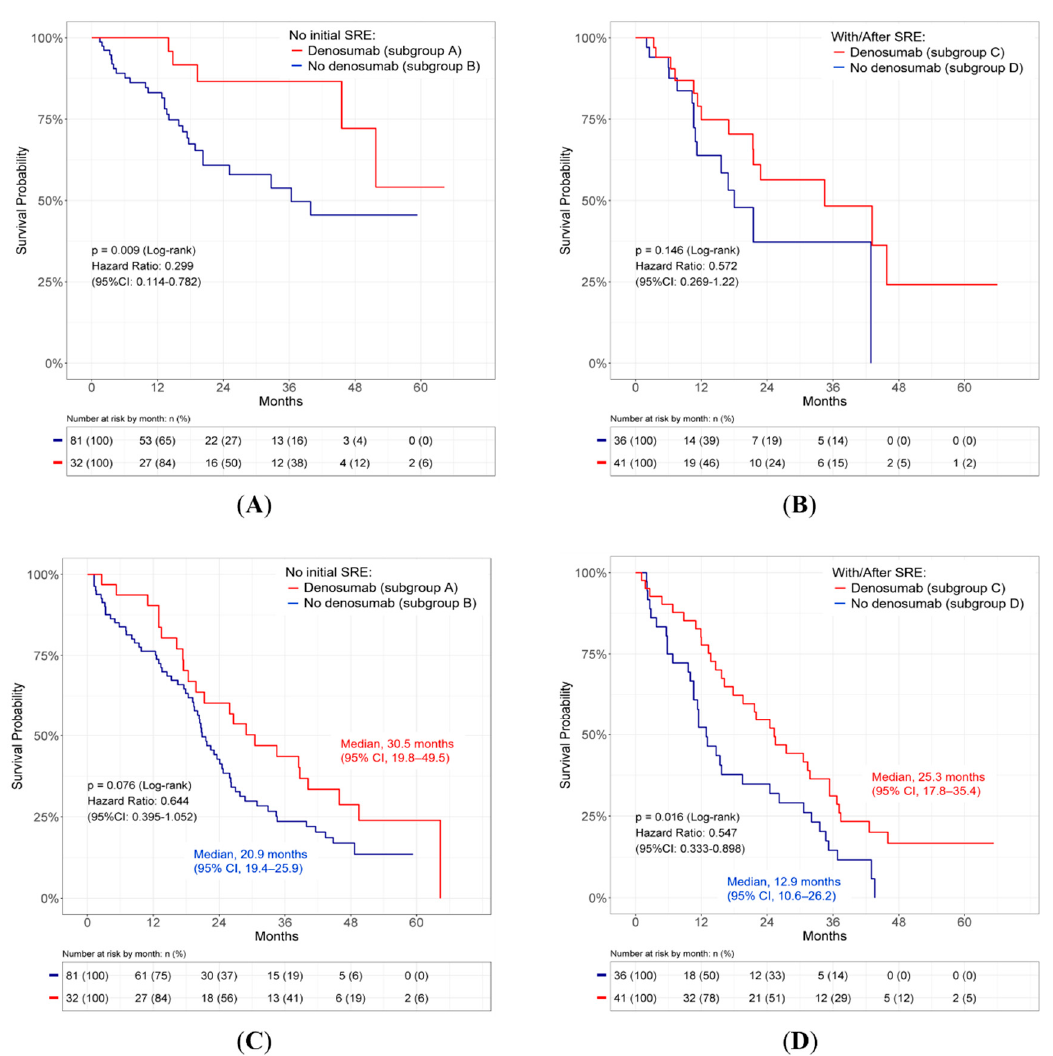
Figure 5. Subgroup analyses of denosumab’s effect on ( A ) SRE-FS in patients without initial SRE who did or did not receive denosumab therapy, ( B ) SRE-FS in patients with pre-existing SREs who received denosumab therapy or in patients with initial SREs who did not receive denosumab therapy, ( C ) OS in patients without initial SREs who did or did not receive denosumab therapy, and ( D ) OS in patients with pre-existing SREs who received denosumab therapy or in patients with initial SREs who did not receive denosumab therapy. CI: confidence interval; EGFR : epidermal growth factor receptor; NSCLC: non-small cell lung cancer; OS: overall survival; SRE-FS: skeletal-related event-free